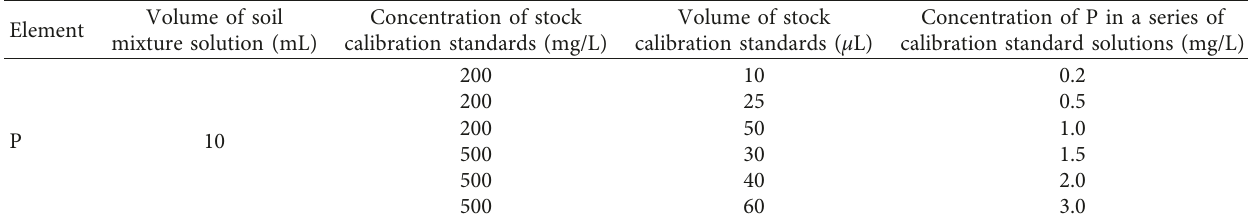
Table 4: Concentrations of the calibration working standards used in